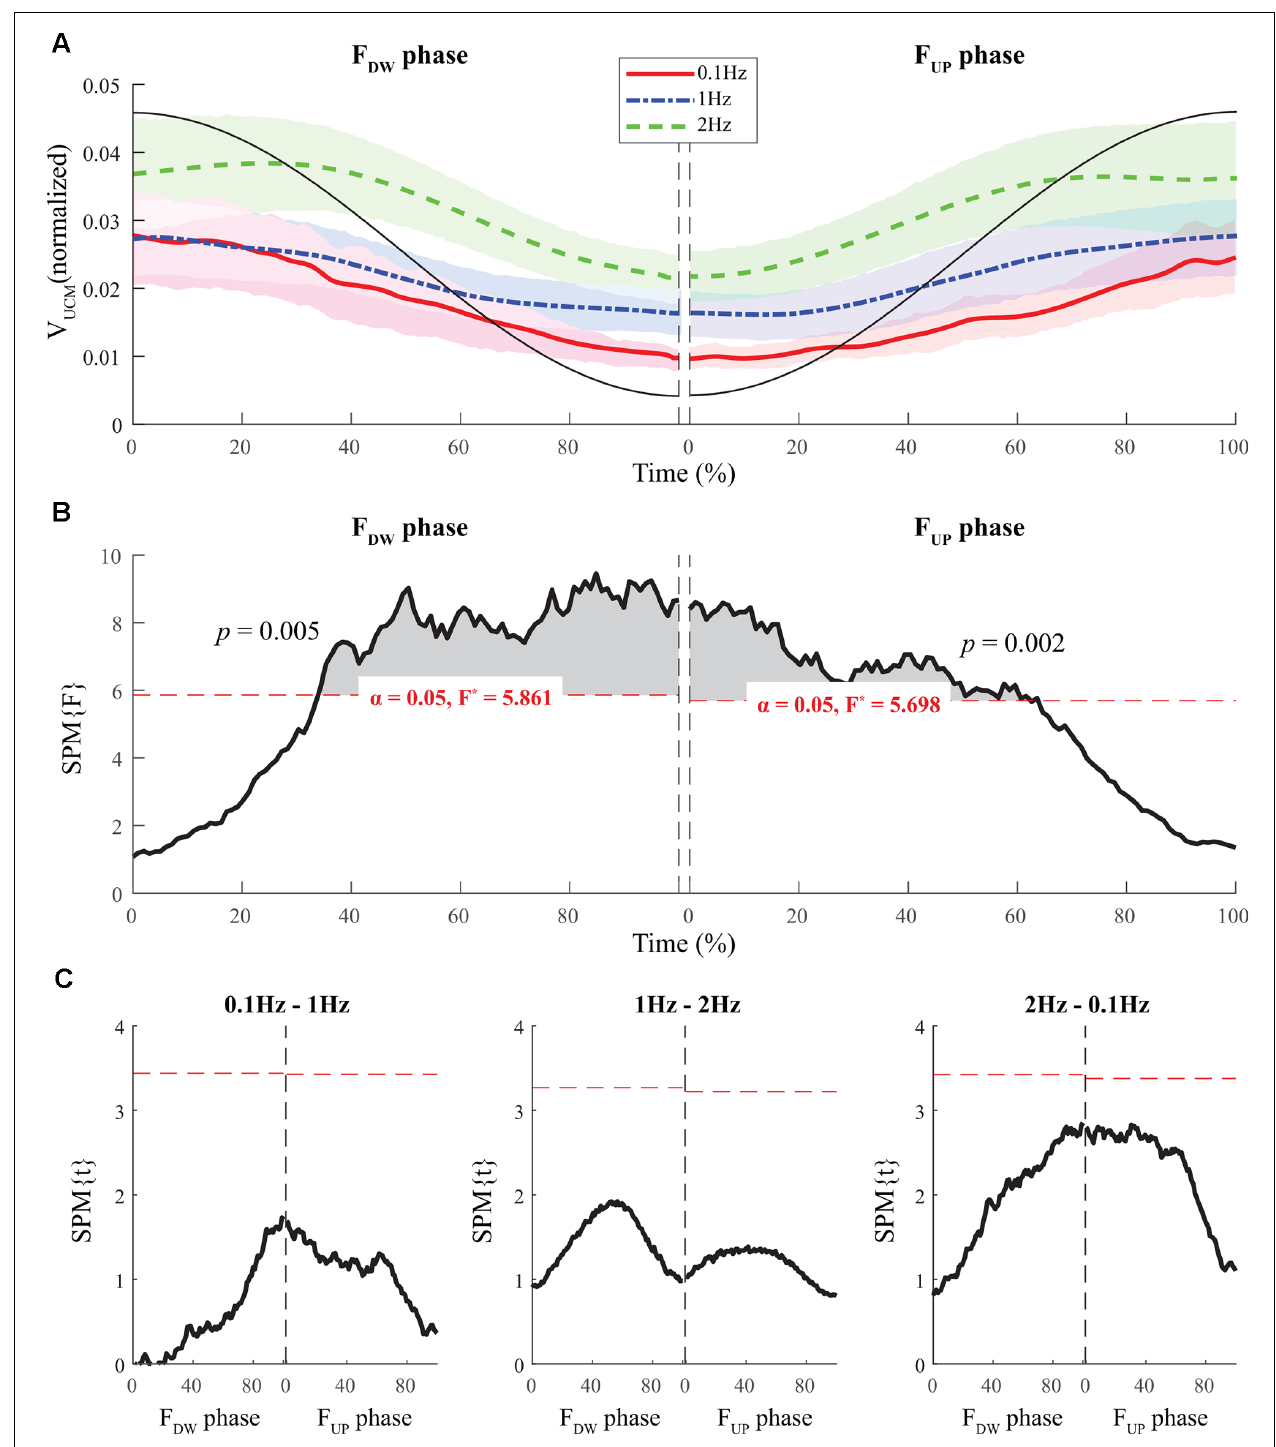
FIGURE 4 | The sample data of total force (black solid line) and the time profiles of the mean values of normalized V UCM across participants for three frequency conditions are presented with standard deviations shades during the F DW ( left panel ) and F UP ( right panel ) phases such that red solid-, blue dashed-, and green dashed-lines present ∆ V time-profiles for 0.1, 1, and 2 Hz, respectively (A) . SPM{F} trajectories on V UCM (black solid line) with repeated measures ANOVA are presented for the F DW ( left panel ) and F UP ( right panel ) phases. The horizontal dotted line in red color indicates the threshold of critical random field theory at α = 0.05 (B) . Post hoc pairwise t -tests (SPM{t}) on V UCM are presented. The horizontal dotted lines in red color indicate the threshold of critical random field theory at p < 0.05 (C)